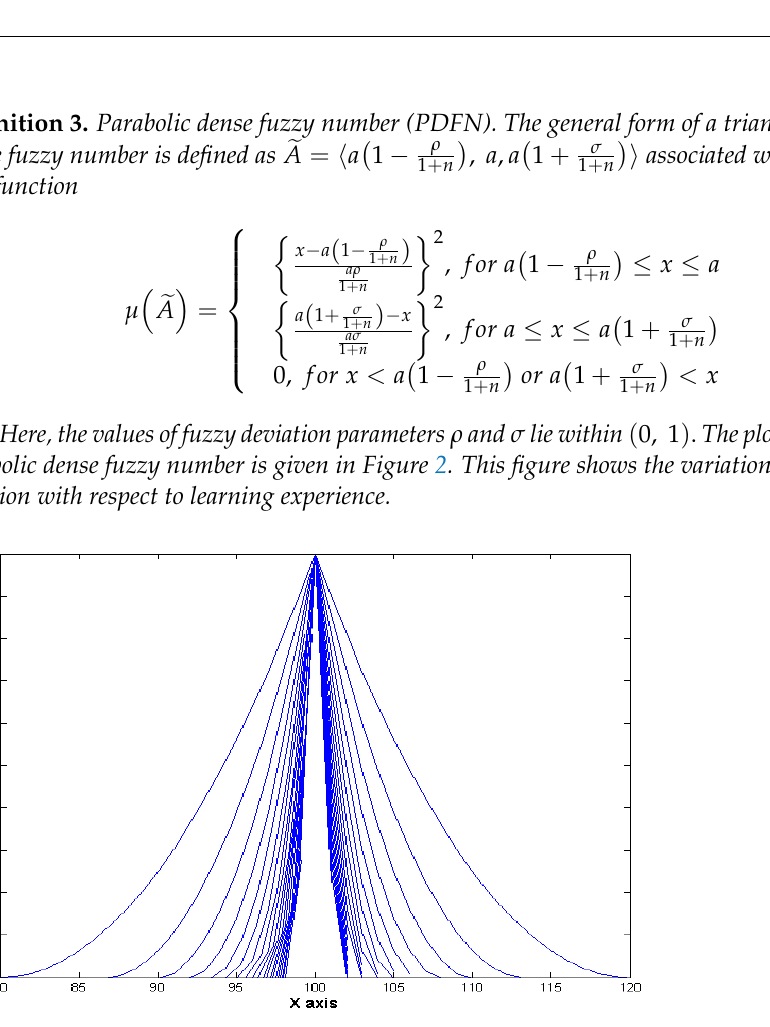
Figure 2. Graph of membership function of PDFN against learning experience.